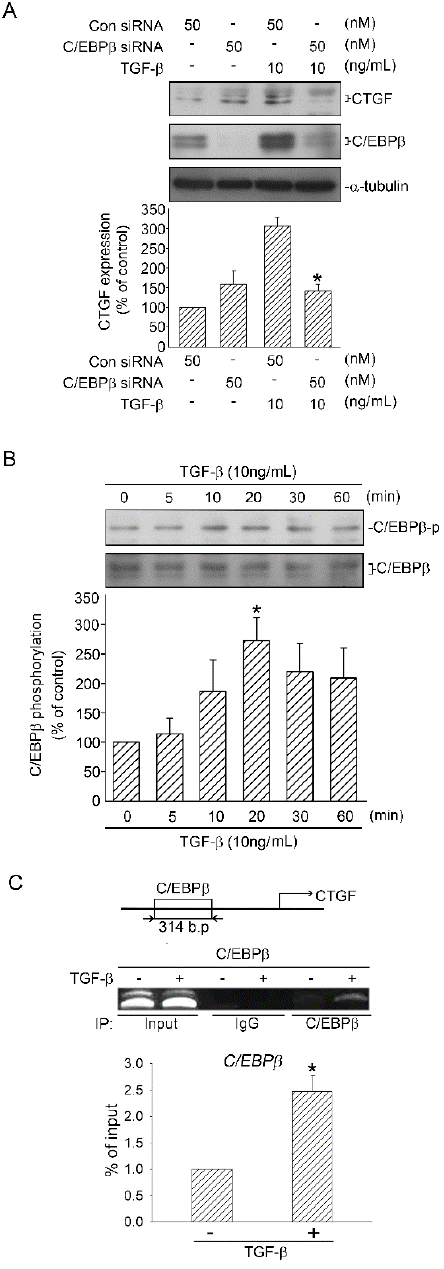
Figure 5. Participation of C/EBP β in TGF- β -induced CTGF expression in human lung epithelial A549 cells. ( A ) A549 cells were transfected with 50 nM control siRNA (con siRNA) and C/EBP β siRNA (50 nM) for 48 h before they were stimulated with TGF- β (10 ng/mL) for an additional 6 h. CTGF and α -tubulin levels were detected in cell lysates through Western blotting. Results are presented as mean ± SEM of four independent experiments. * p < 0.05, compared with TGF- β plus the control siRNA group. ( B ) Cells were stimulated with TGF- β (10 ng/mL) for 0–60 min, after which the levels of C/EBP β phosphorylation and C/EBP β in cell lysates were immunodetected with specific antibodies. Results are presented as mean ± SEM of five independent experiments. * p < 0.05, compared with the control group without TGF- β treatment. ( C ) Incubated cells were stimulated with TGF- β (10 ng/mL) for 20 min and detected using the ChIP assay, as mentioned in the “Materials and Methods” section. The typical traces indicated the three independent experiments that yielded similar results. Results are presented as mean ± SEM of three independent experiments. * p < 0.05, compared with the control group without TGF- β treatment.